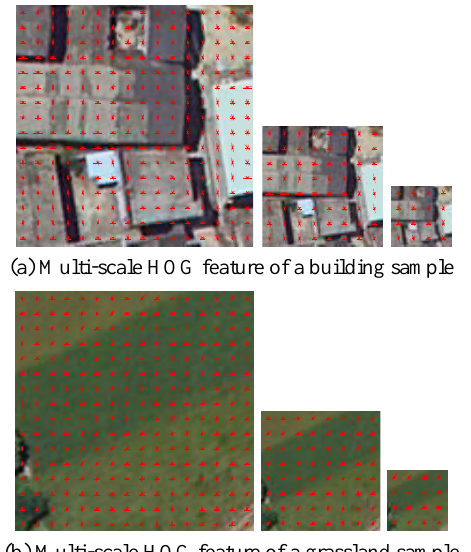
Figure 2. The TC-SIFT-SP representation of two objects, (a) is of a building, (b) is of a grassland.